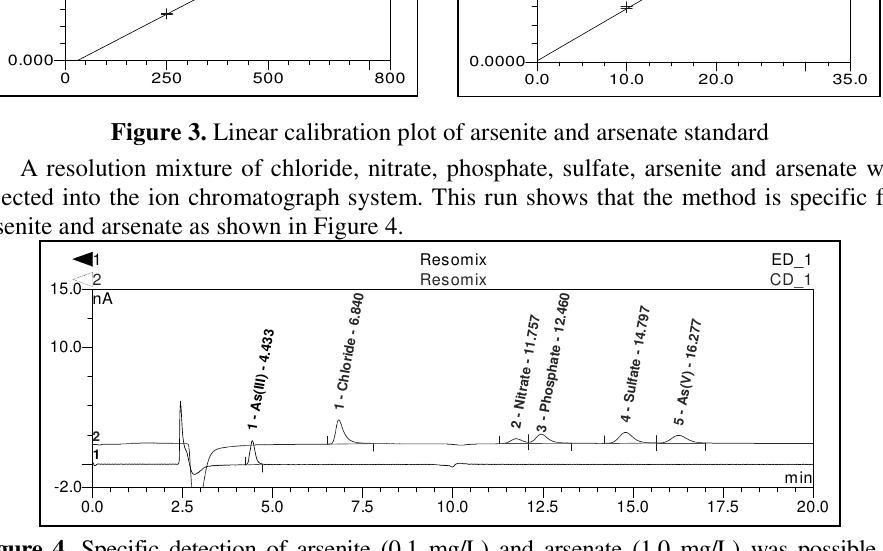
Figure 4 . Specific detection of arsenite (0.1 mg/L) and arsenate (1.0 mg/L) was possible in presence of chloride (0.5 mg/L), nitrate (1.0 mg/L), phosphate (1.0 mg/L) and sulfate (1.0